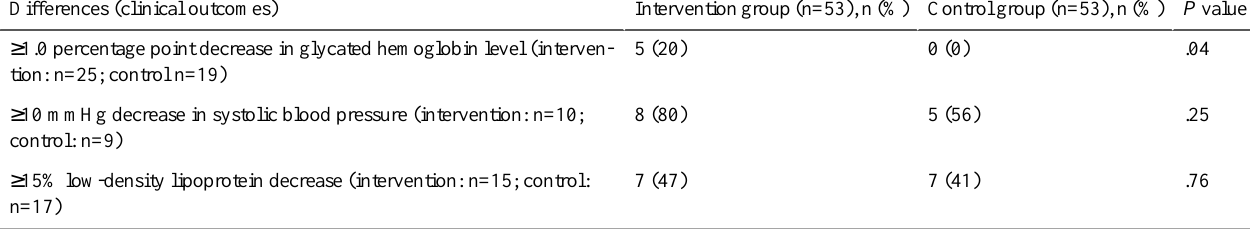
Table 3. Differences in clinical